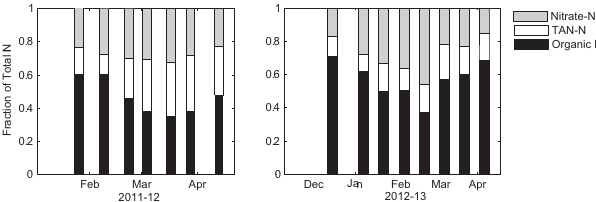
Figure 7. Snowpack total N distribution for 2011–2012 (left) and 2012–2013